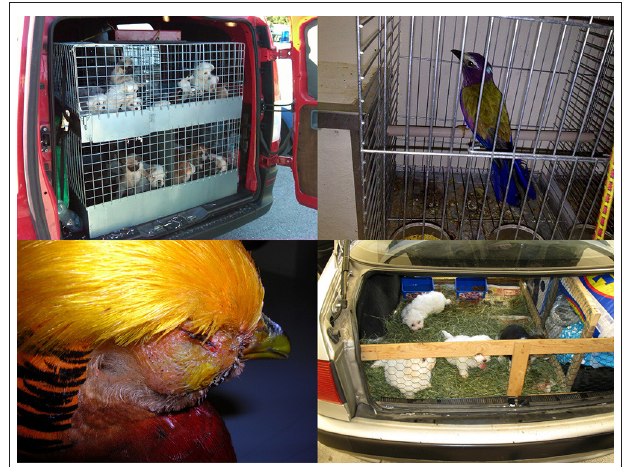
FIGURE 1 | Although major hotspots of mammal hosts occur in the New and Old World tropics (South America and Eastern Africa, particularly) more zoonoses are concentrated in northern latitudes, Eastern Africa, and Southeast Asia (13). According to these findings, it is very important to emphasize that zoonoses are not “exotic diseases” for North American and European citizens (16). In fact, zoonotic agents such as Toxocara spp., Chlamydia psittaci, Salmonella spp., Giardia spp., and other viral and bacterial zoonotic diseases are routinely diagnosed among pets from illegal animal trade ( 16) sold to unwitting parents of children and adolescents (Images credits Paolo